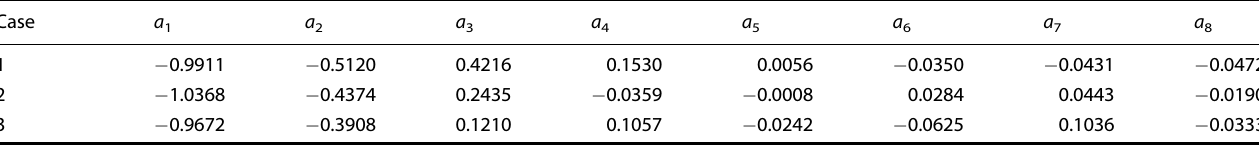
Table 1. Optimized a n values in different cases.